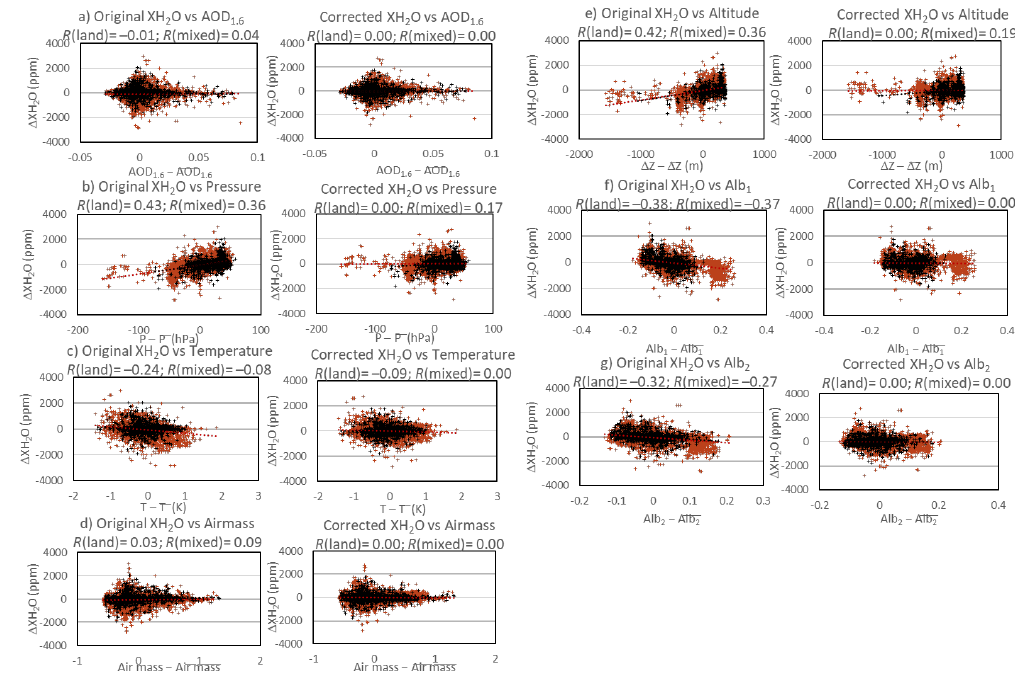
Figure 3. Scatter plots between ∆ XH 2 O calculated from original GOSAT SWIR XH 2 O data (left panels) or from GOSAT SWIR XH 2 O data corrected by bias-correction method (E) (right panels) and auxiliary parameters ( a ) AOD 1.6 , ( b ) surface pressure, ( c ) temperature shift, ( d ) air mass, ( e ) altitude, ( f ) Alb 1 , and ( g ) Alb 2 for case 1. Red symbols indicate GOSAT gain H land data, and black symbols indicate GOSAT gain H mixed for case 1. Red symbols indicate GOSAT gain H land data and black symbols indicate GOSAT gain H mixed data. The dotted lines are the fitted regression lines. ∆ XH 2 O = GOSAT XH 2 O − TCCON XH 2